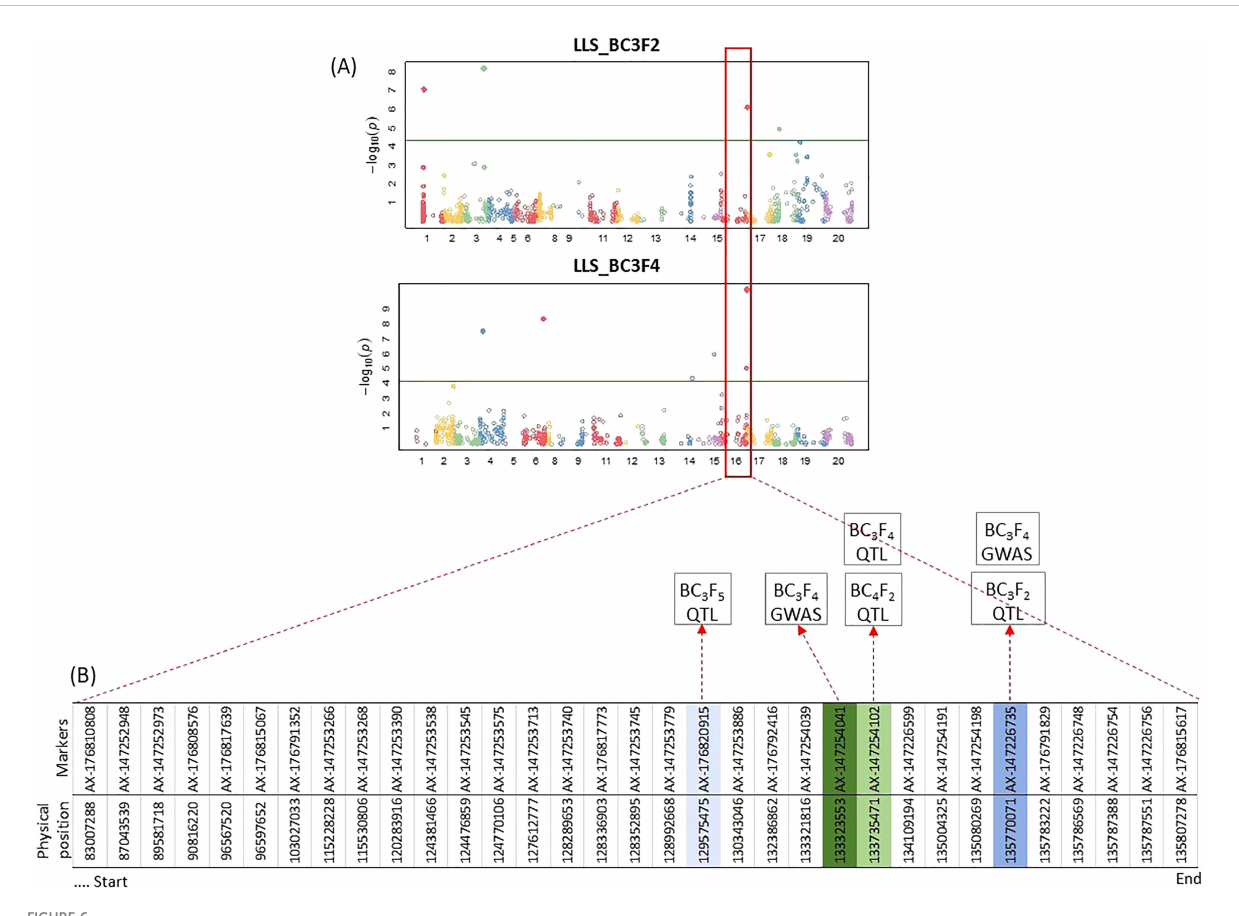
FIGURE 6 (A) Manhattan plot representing the results of GWAS of LLS using SNPs obtained from Axiom data for BC 3 F 2 and BC 3 F 4 generations. Each dot represents an SNP. The green line represents signi fi cance threshold (FDR = 0.05). No signi fi cant SNPs were identi fi ed for BC 3 F 5 and BC 4 F 2 . (B) Distribution of signi fi cant markers identi fi ed from QTL and GWAS analyses in chromosome B06 on populations BC 3 F 2 , BC 3 F 4 , BC 3 F 5 , and BC 4 F 2 . Colored boxes of markers represent signi fi cant SNPs/QTLs from the GWAS/QTL analyses for the different